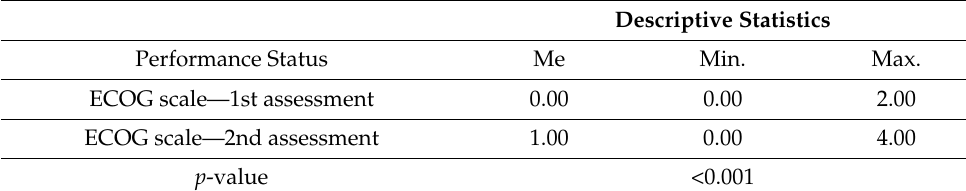
Table 2. Assessment of performance status using the ECOG scale.